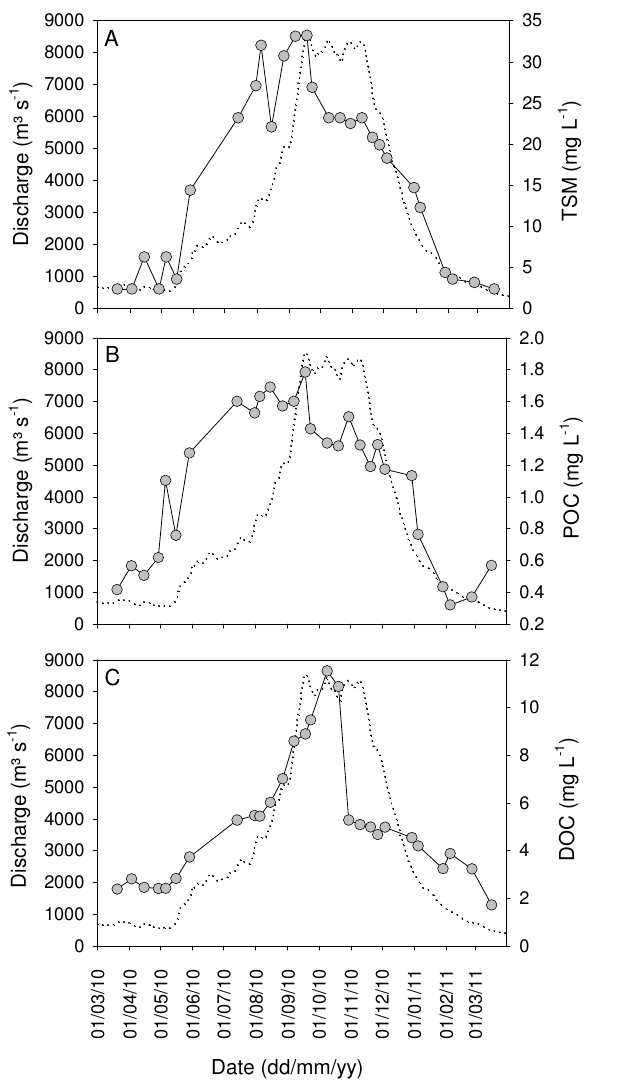
Fig. 3. Seasonal variations of daily discharge (dotted lines) and (A) total suspended matter (TSM), (B) particulate organic carbon, and (C) dissolved organic carbon, in the Oubangui River at Bangui be- tween March 2010 and March 2011.